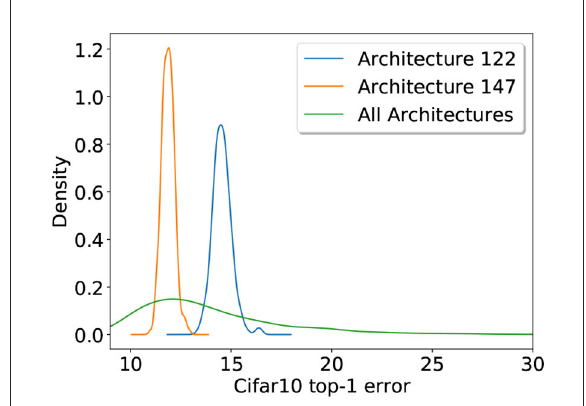
FIGUREA3 Error distributions on Cifar10 of two architectures (122, 147) both trained from scratch 250 times as well as the Cifar10 error distribution of all 500 architectures. The plot shows that the variability caused by changing architecture is much larger than the one caused by random training